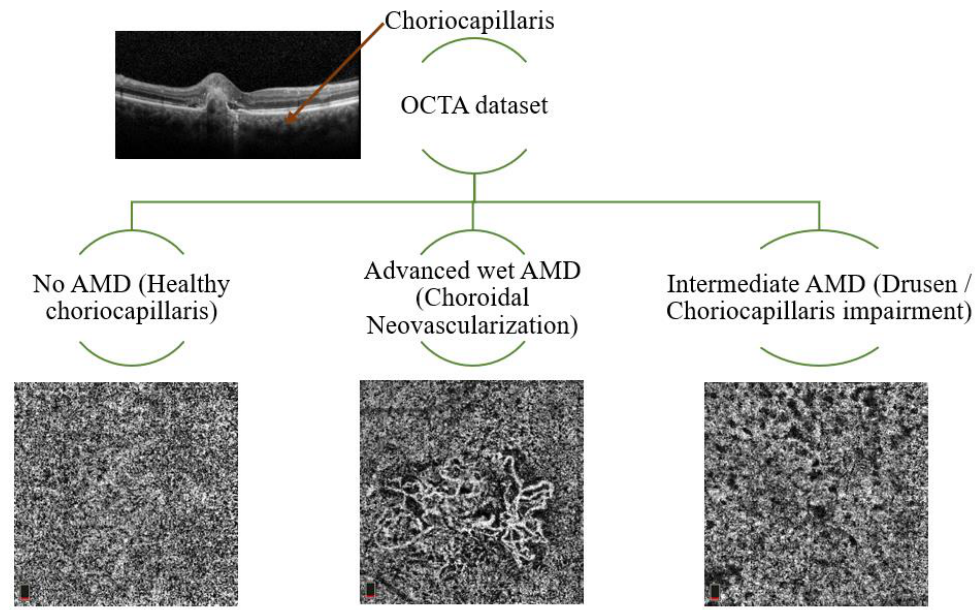
Figure 1. Classification of three types of OCTA choriocapillaris images (no AMD, advanced wet AMD, intermediate AMD). On the top-left: the OCTA cross-sectional B-scan showing retinal layers. 158